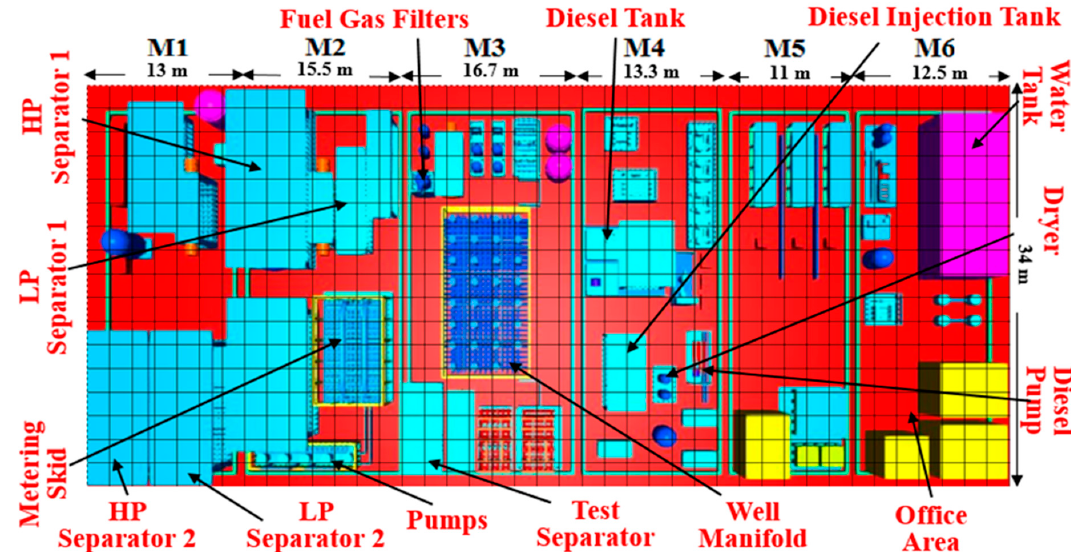
Figure 3. Grid-based approach. Reproduced with permission from Niazi et al. [33], Process Safety Progress; published by Wiley, 2020.